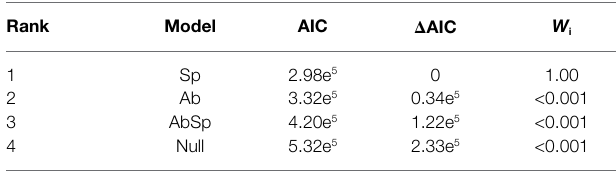
TABLE 1 | Model selection table for predicting species interaction frequencies in the observed